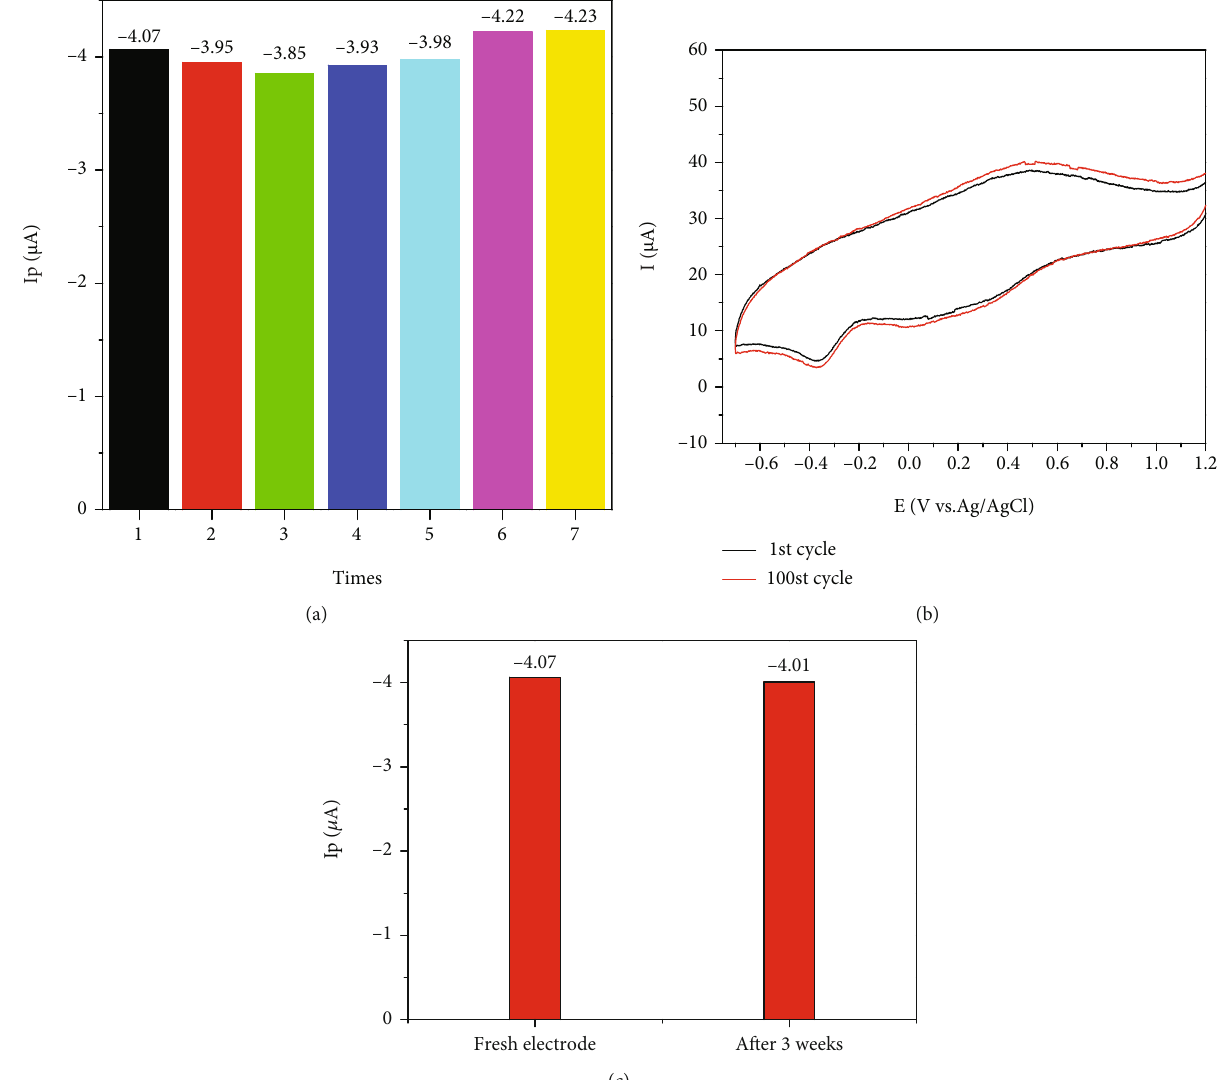
Figure 7: (a) The peak current values of DPVs of 1.278 μ M tetracycline in 1M H 0.641 μ M tetracycline in 1M H SO detected by MIL-53 (Fe)/GCE in the fi rst and 100th cycle. (c) The I p values of DPVs of 1.278 μ M 2 4 tetracycline in 1 M H SO over MIL-53 (Fe)/GCE and that after 3 weeks. 2 4 Table 2: Detection of tetracycline in tap water and river water.